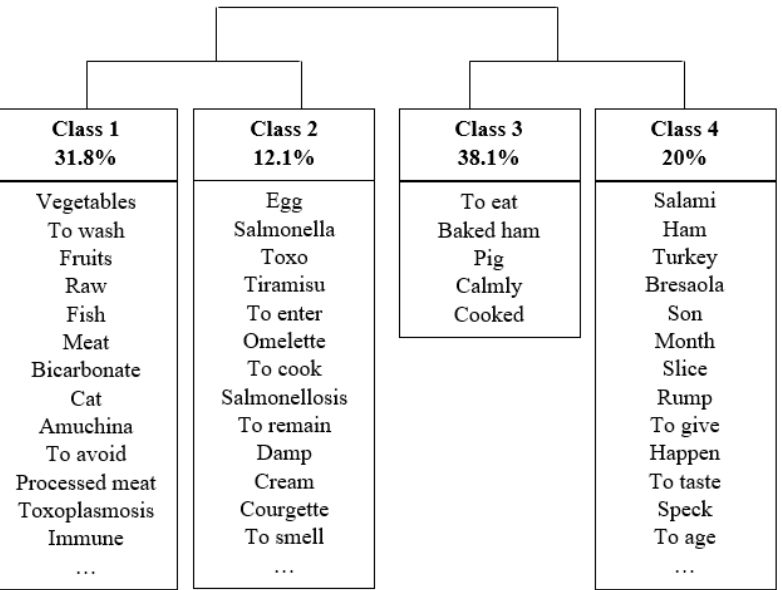
Figure 3. Dendrogram of the classes related to food risks during pregnancy. The most associated words listed are ordered by the chi-square index.